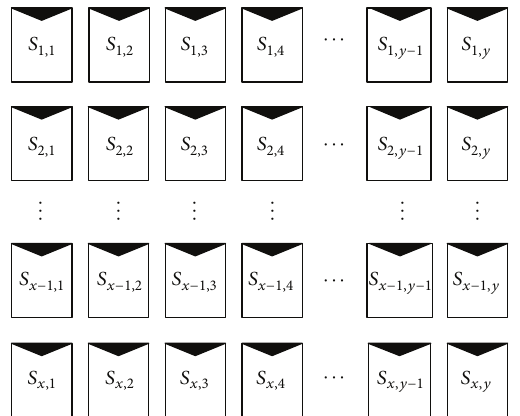
), ( 𝑉 , 𝐼 ), and ( 𝑉 , 0). Figure6:Ageneralnetworkconnectionofsolarcellsinanassembly sc mp sc oc comprising 𝑥 rows and 𝑦 columns of